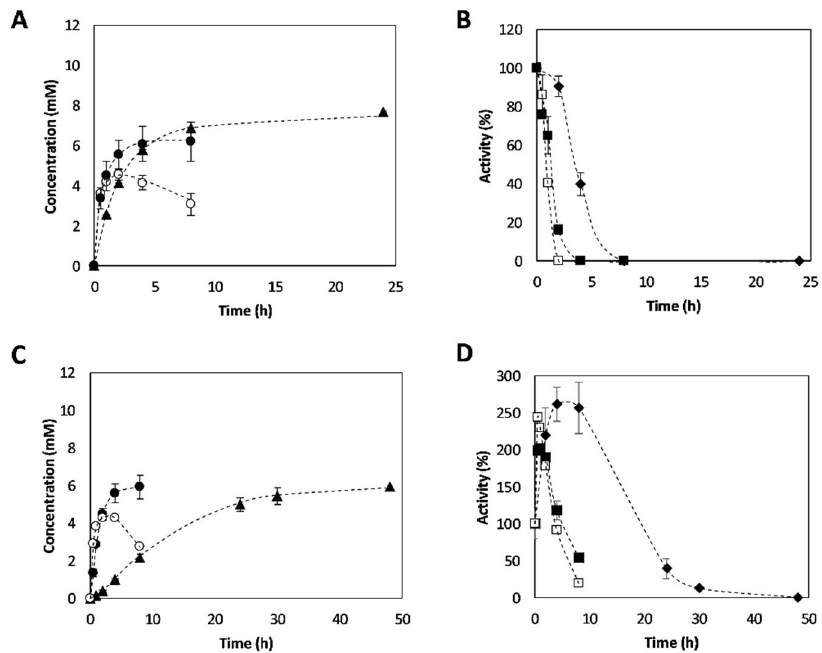
). Reaction (cid:31)